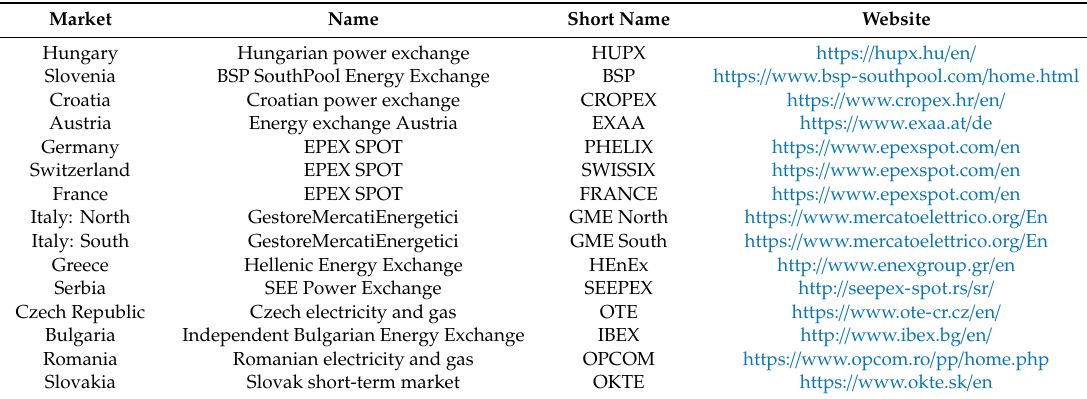
Table 1. Websites for power pools /